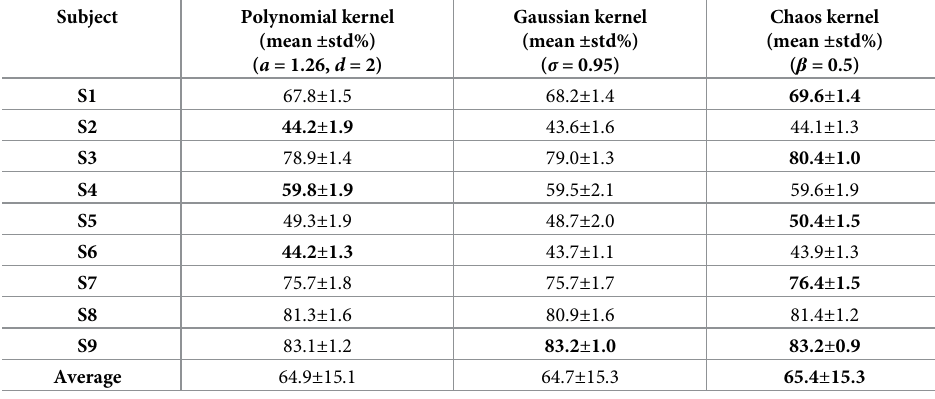
Table 2. Comparison of 3-kind kernels based on RVM on session